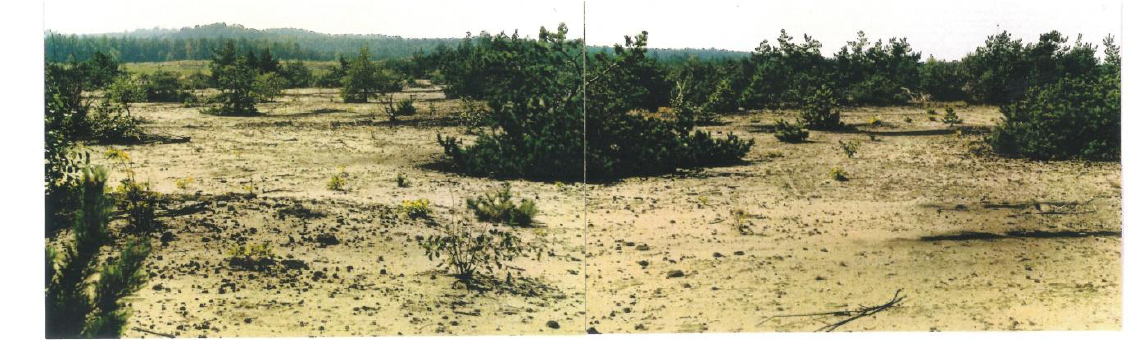
Fig. 3. Aeolian coversands in Starczynów „Desert” ( J. Pełka-Gościniak